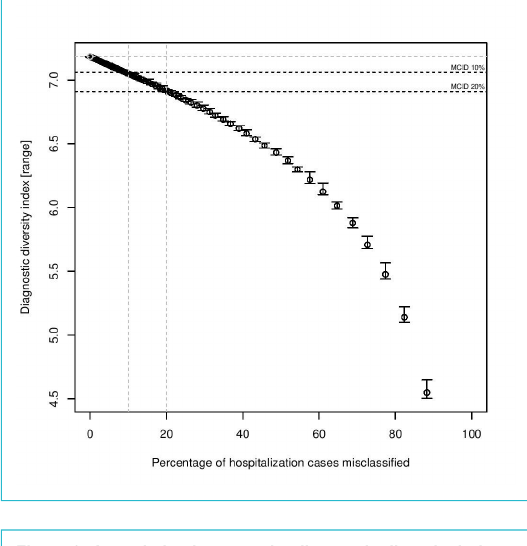
Figure 3: Association between the diagnostic diversity index and the institutions’ caseload. The 10% misdiagnosis threshold (minimum clinically important difference; MCID) is represented by a horizontal dashed line.Local regression (loess) representing a smooth curve through the set of data points is depicted. In general, institutions with an annual caseload >7217 hospitalisation cases (intersection point where the loess regression crosses the 10% misdiagnosis diagnostic diversity index [DDI] threshold) were more likely to have an adequate DDI.